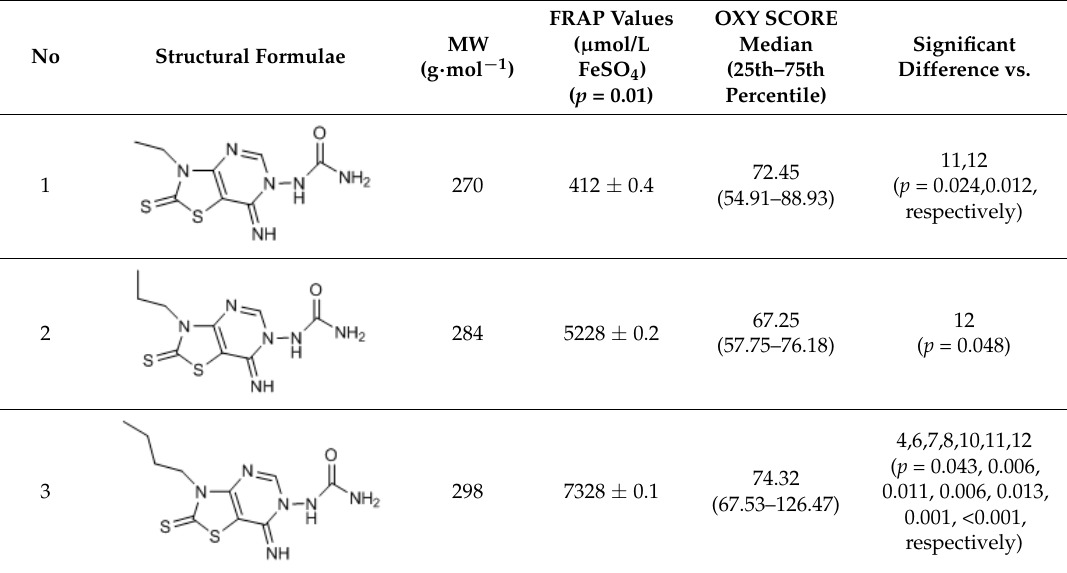
Table 1. FRAP assay and Oxy Score values.